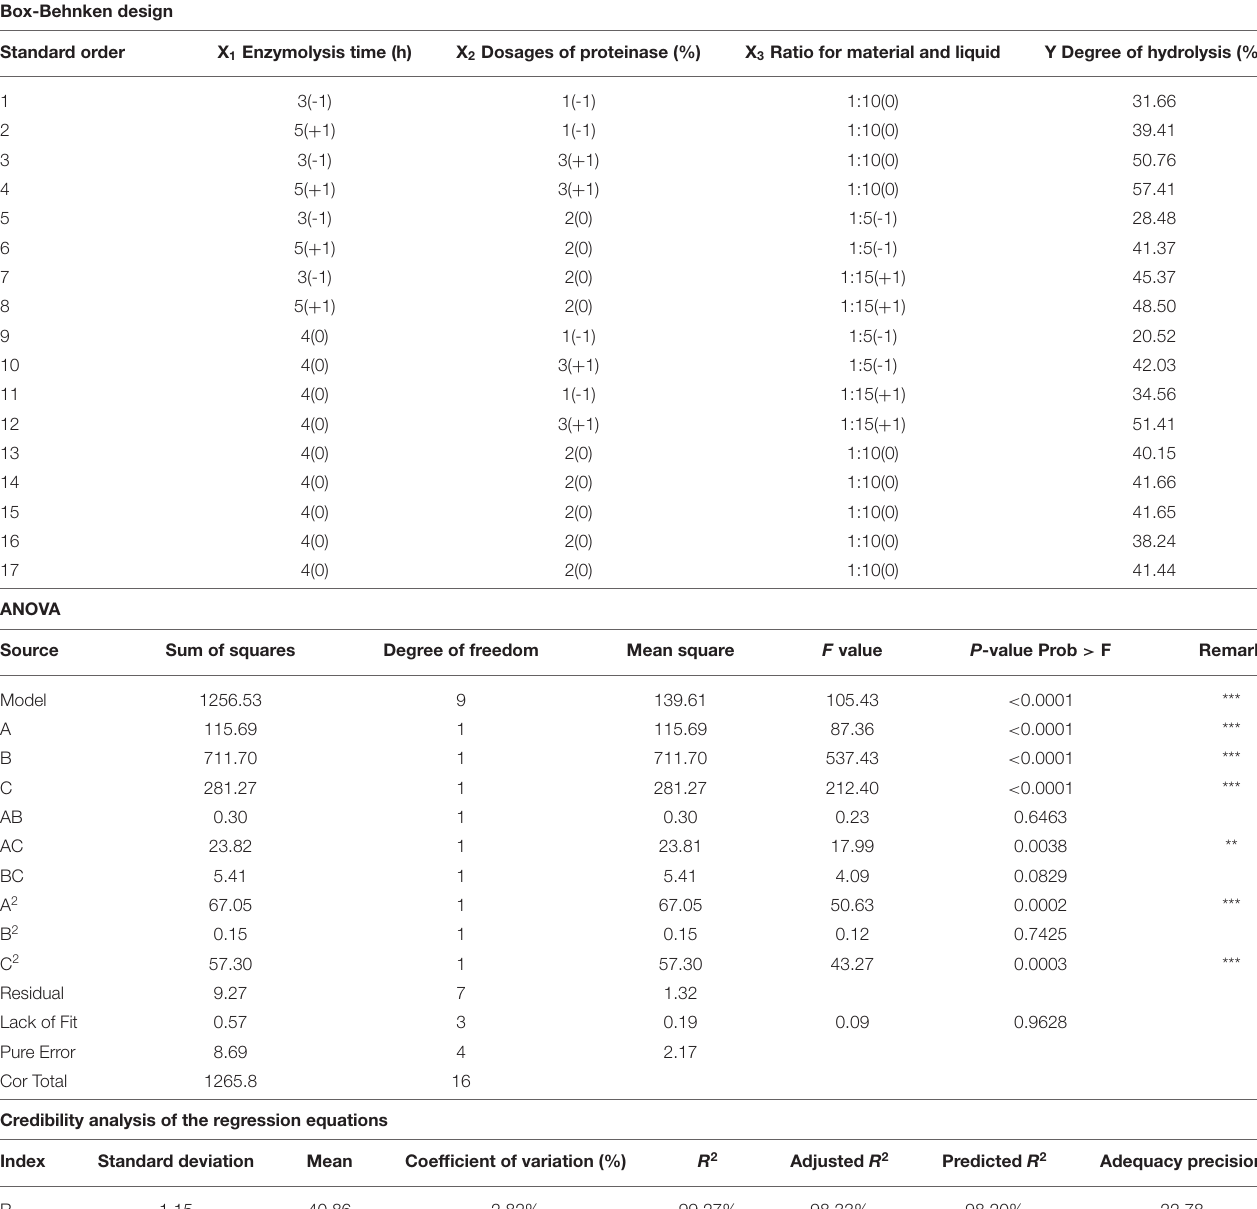
TABLE 1 | Box-Behnken design matrix with matrix experimental results of the DH and analysis of variance for the response surface model. Box-Behnken